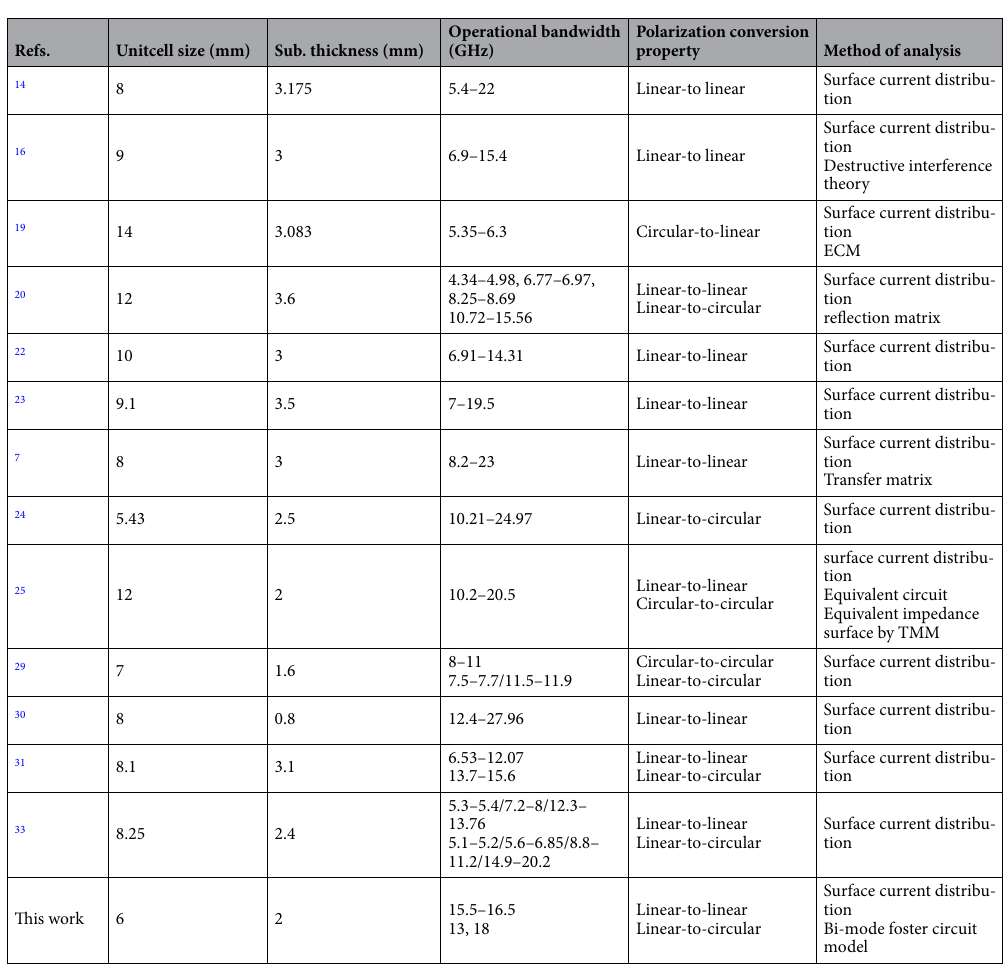
Table 1. Comparison between the proposed structure and similar